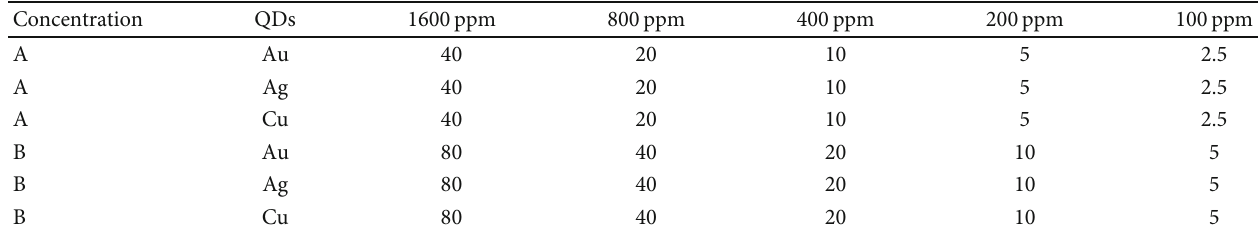
Table 1: Equivalence of mix Qs-QDs tested with NPs (mg) present in each